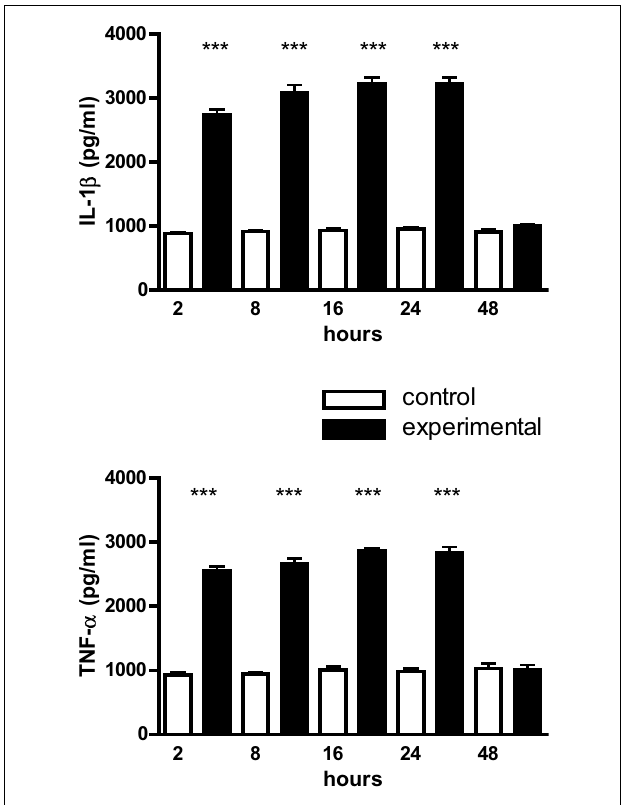
FIGURE 1 | IL-1 β andTNF- α production by mouse calvarial osteoblasts . Osteoblasts in monolayer culture were subjected to a cyclic tensile strain (6s every 90s) for 2–48h and the culture media assayed for IL-1 β andTNF- α by ELISAs. Results are expressed as mean ± SEM for 10 cultures. ***Experimental significantly greater than control. P < 0.001.